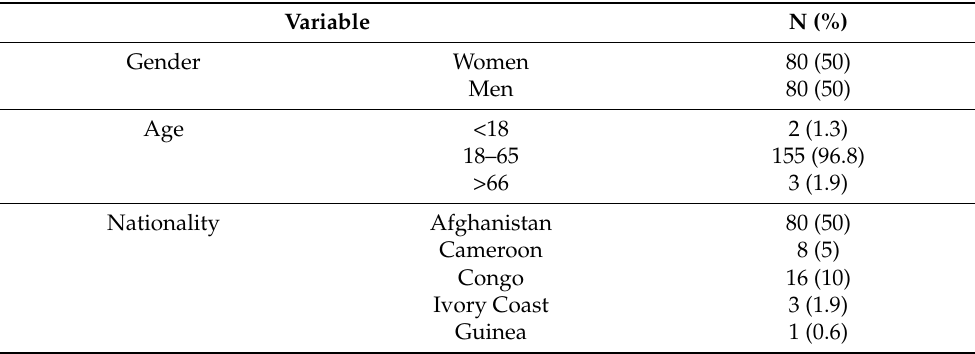
Table 1. Sociodemographic data of the